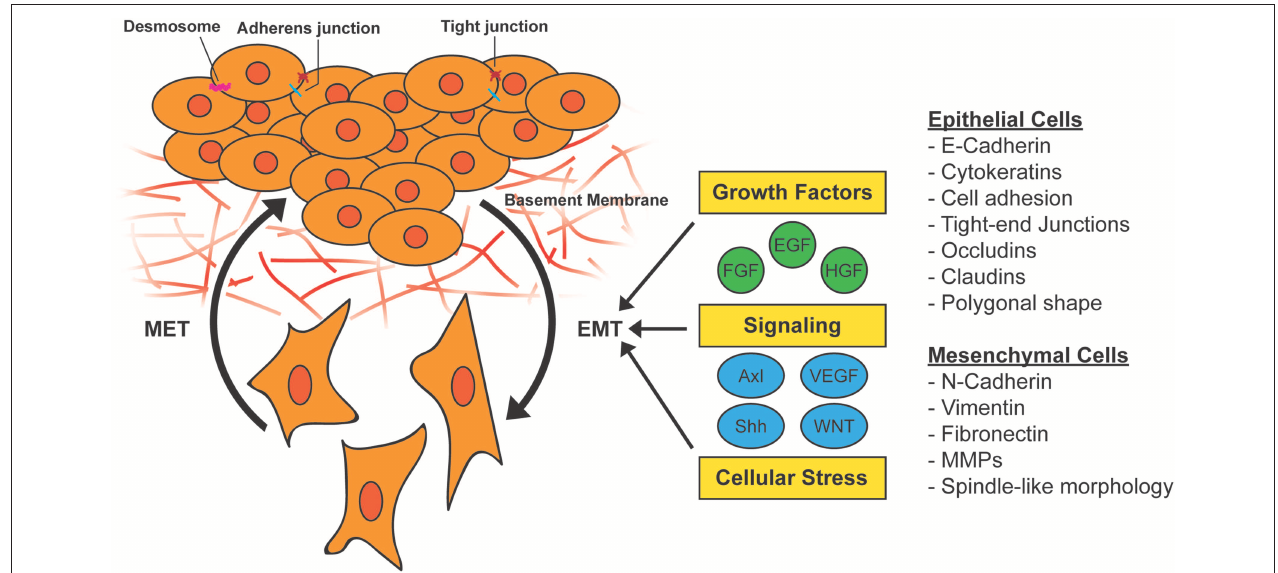
FIGURE 1 | Activation of epithelial-to-mesenchymal transition (EMT). During EMT, epithelial cells lose their cell-to-cell adhesion and adopt a more spindle-like morphology due to the expression of mesenchymal markers. This morphology change results in the ability to escape the basement membrane and invade and survive stressful situations, including therapy. EMT can be induced by a variety of growth factors, signaling pathways, and cellular stress such as hypoxia and nutrient deprivation. MET, mesenchymal-to-epithelial transition; MMP, matrix